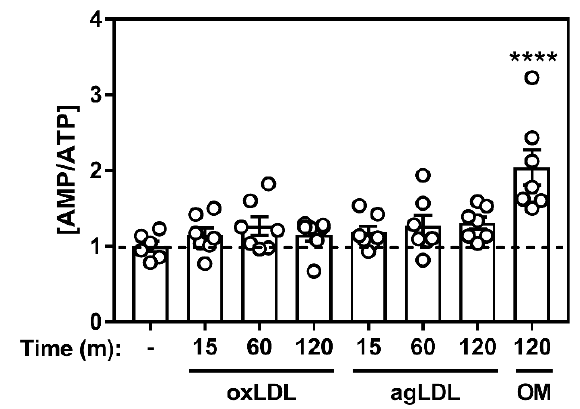
Figure 3. Acute incubation with atherogenic lipoproteins minimally shifts the energy status in cultured macrophages. Macrophages were cultured in the presence of oxidized (oxLDL) (50 µg/mL), agLDL (50 µg/mL), or oligomycin (OM) (5 µM) as a positive control. Data represent the mean ± SEM and expressed relative to naïve macrophage control (dashed line), where **** represents p < 0.0001 compared to vehicle-treated time 0 min.